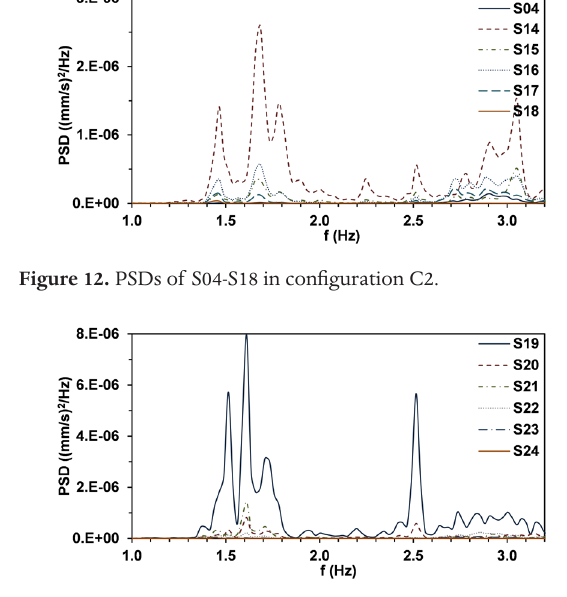
Figure 13. PSDs of S19-S24 in configuration